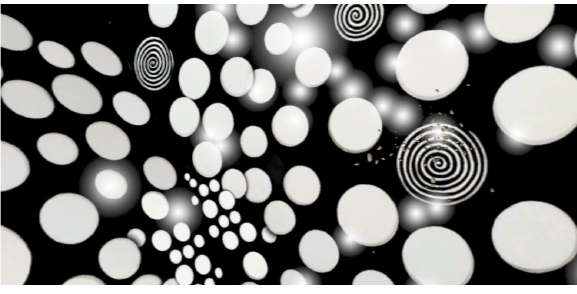
Figure 7. AudioVirtualizer scene